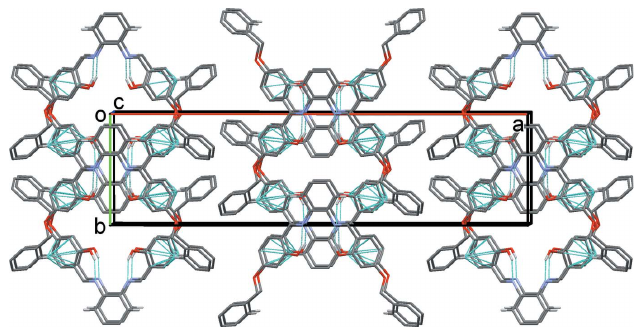
Figure 2 Crystal packing of compound (I) viewed along the c axis, with the O— H (cid:2)(cid:2)(cid:2) N intramolecular hydrogen bonds and the C—H (cid:2)(cid:2)(cid:2) (cid:2) interactions (see Table 1) illustrated as dashed lines.